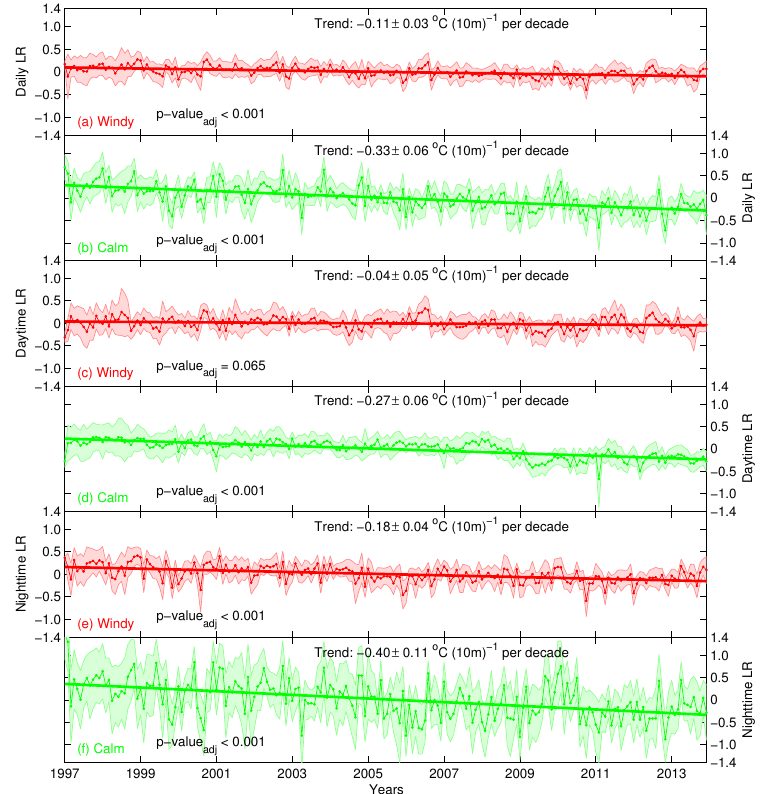
Figure 6. Trends and variations of monthly lapse rate (LR) ( y axis units are ◦ C (10m) − 1 ) classified by windy and calm conditions for daily (a) and (b) , daytime (c) and (d) , and nighttime (e) and (f) from 1997–2013. Windy conditions were the days that mean wind speeds were above the 87% percentile in a month (i.e., 5 windiest days in each month), and calm conditions were the days where the mean wind speed was below the 17% percentile (i.e., 5 calmest days for each month). The straight lines are least squares trends ( ◦ C (10m) − 1 per decade) with adjusted p values shown. The ± values define the 95% confidence intervals for trends. The shaded region shows the standard deviation of 44